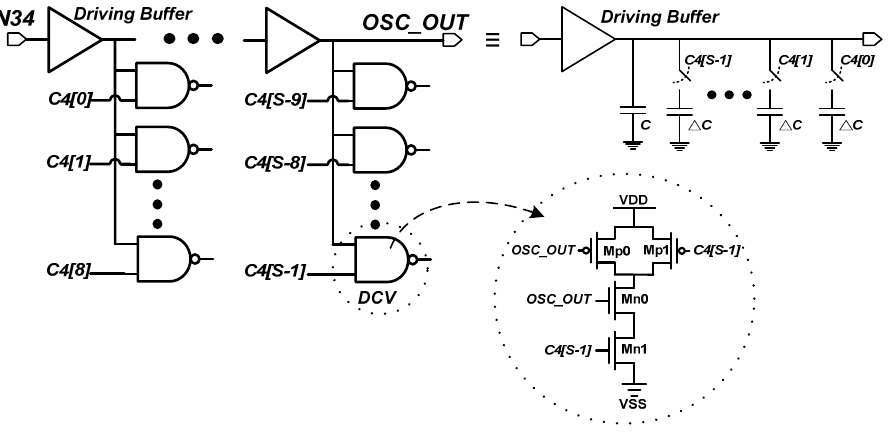
Figure 6. The circuit diagrams of the 4th delay-tuning stage (DTS).